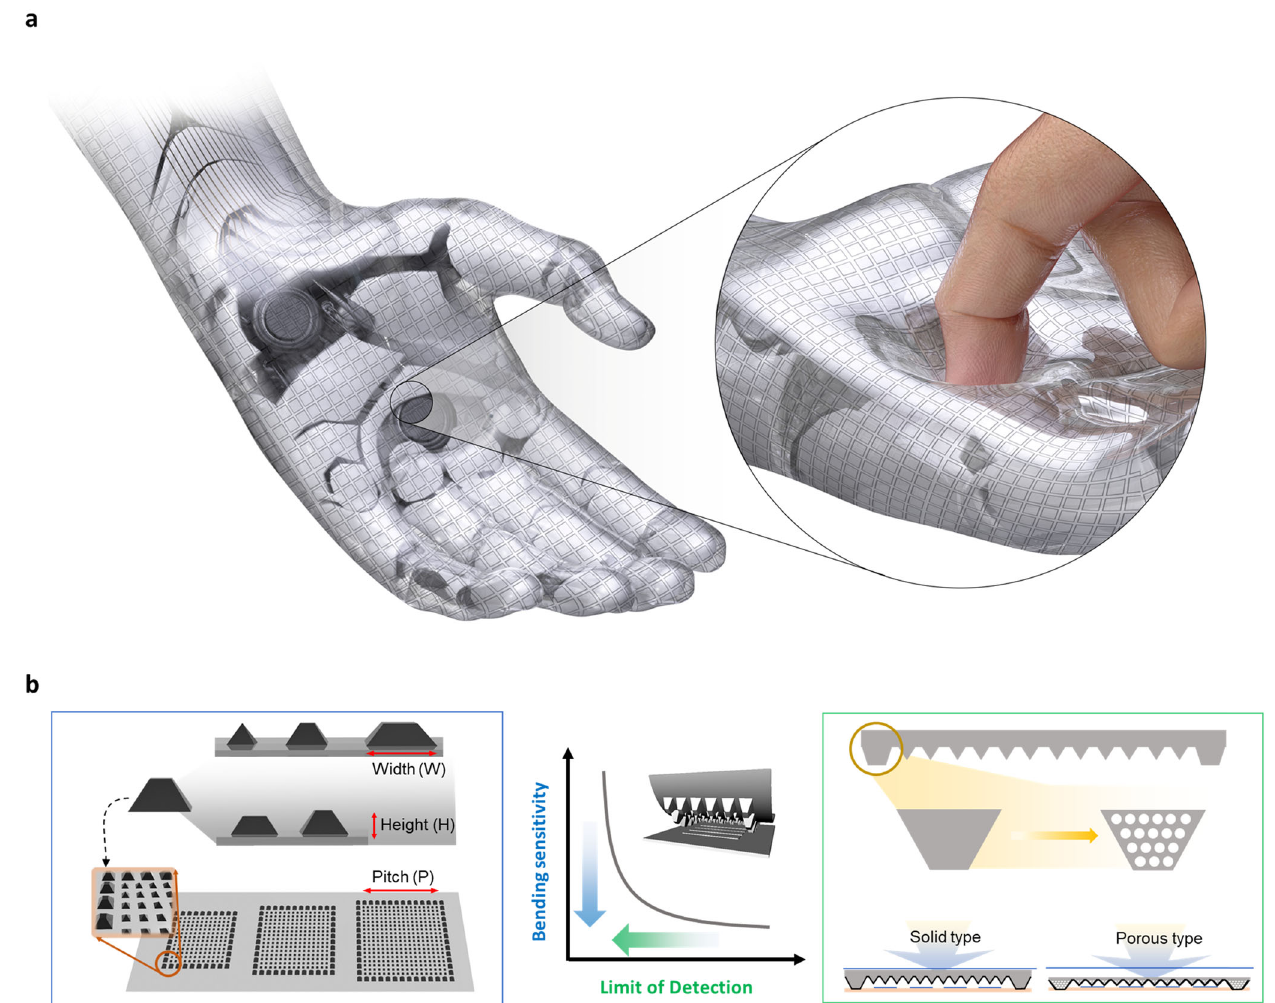
Fig. 1 Overall concept of MDPS. a Schematic illustration of MDPS application for soft robotics and electronics. b Illustration of the multiscale microstructures for optimizing bending insensitive property (left) and the introduction of porous structure to overcome the trade-off relationship between bending sensitivity and